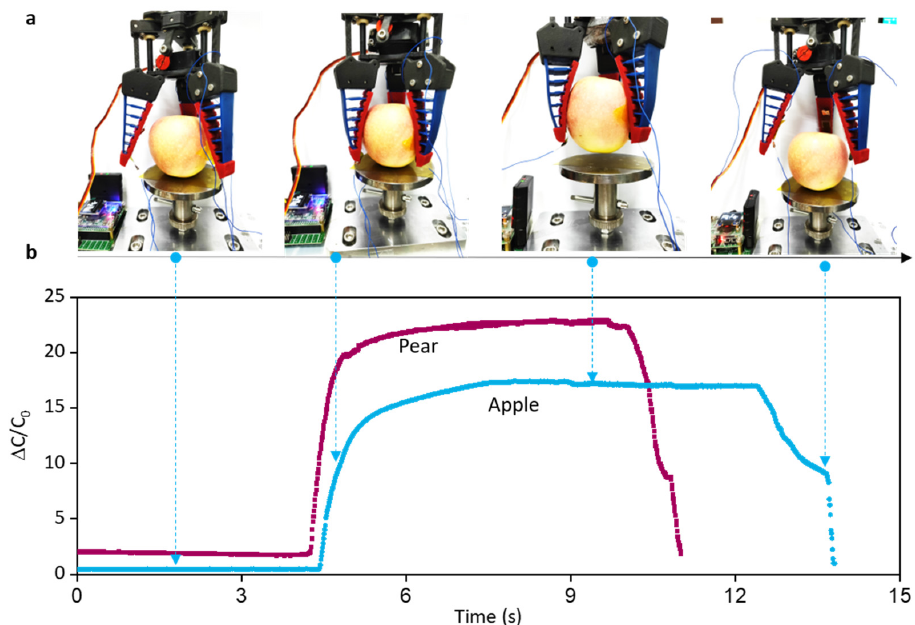
Figure 8. Application of the sensor on flexible robotics. ( a ) The process to grasp and release apple; ( b ) Corresponding steps for the soft manipulator to grasp and release the apple and pear sample.